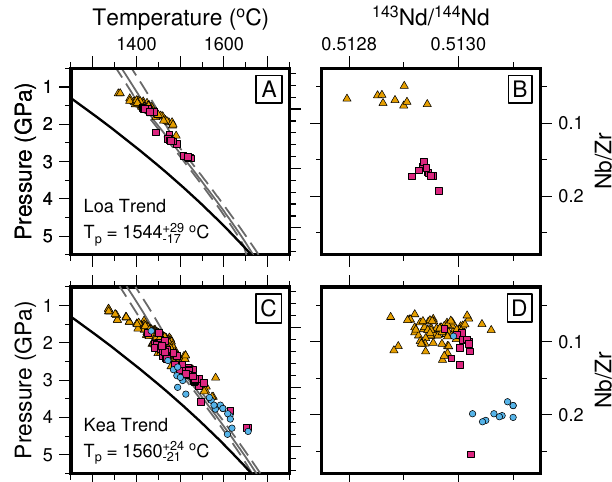
Figure 6: Comparison between Loa and Kea trends. [A] Tem- perature plotted as function of depth/pressure for Mauna Loa data. Figure set-up same as Figure 5. Mauna Loa trend in- cludes data from L¯ana ‘ i, Kaho ‘ olawe, the southwesterly Hawai- ian volcanoes of Hual¯alai and Mauna Loa, as well as Penguin Bank. [B] 143 Nd/ 144 Nd ratios as function of Nb/Zr. [C]–[D] Same as panels [A] and [B] for Mauna Kea trend which includes data from Moloka ‘ i, Maui and the northeasterly Hawaiian volcanoes (Kohala, Mauna Kea and